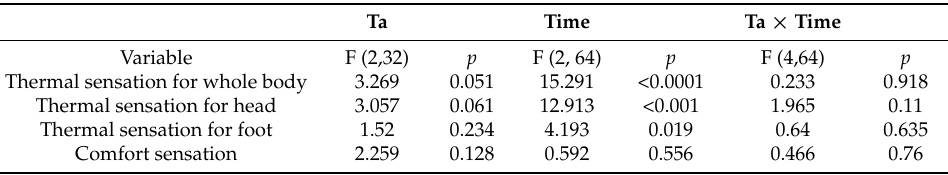
Table 4. Effects of Ta and timing on thermal comfort.